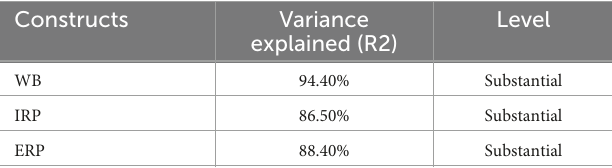
TABLE 6 Variance explained by exogenous